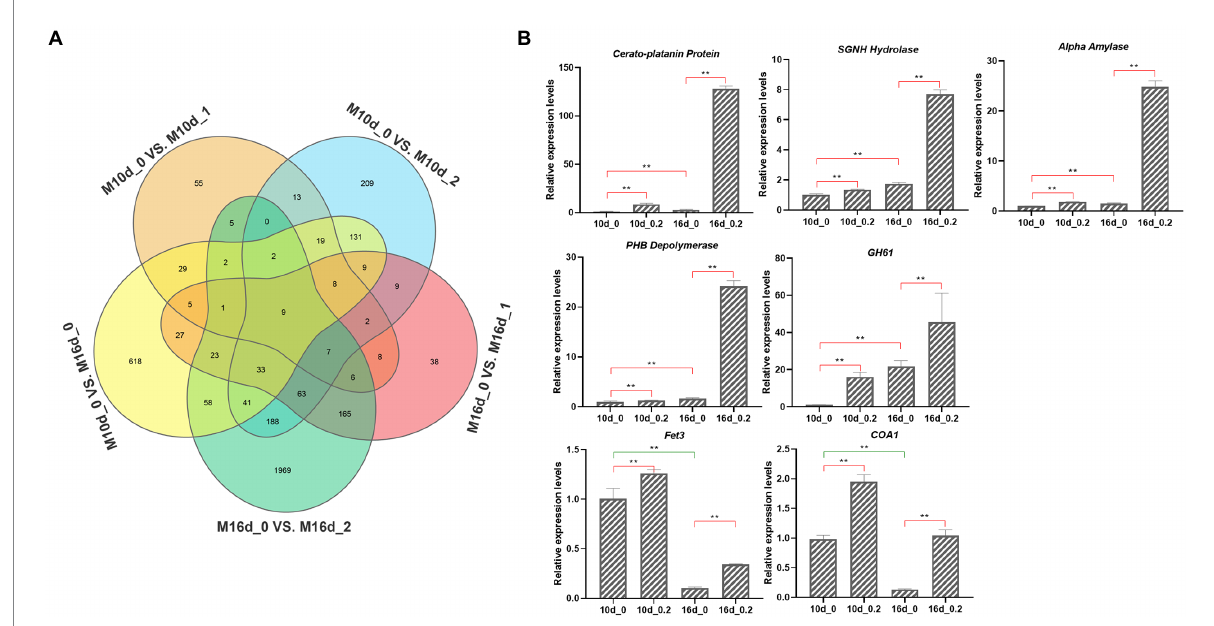
FIGURE 4 Transcriptomic analysis of S. vaninii mycelium. (A) Venn diagram of differential expression genes (DEGs). (B) qRT-PCR analysis of seven candidate genes. Four biological replicates were analyzed. Data are shown as means ± SEM. ** p <